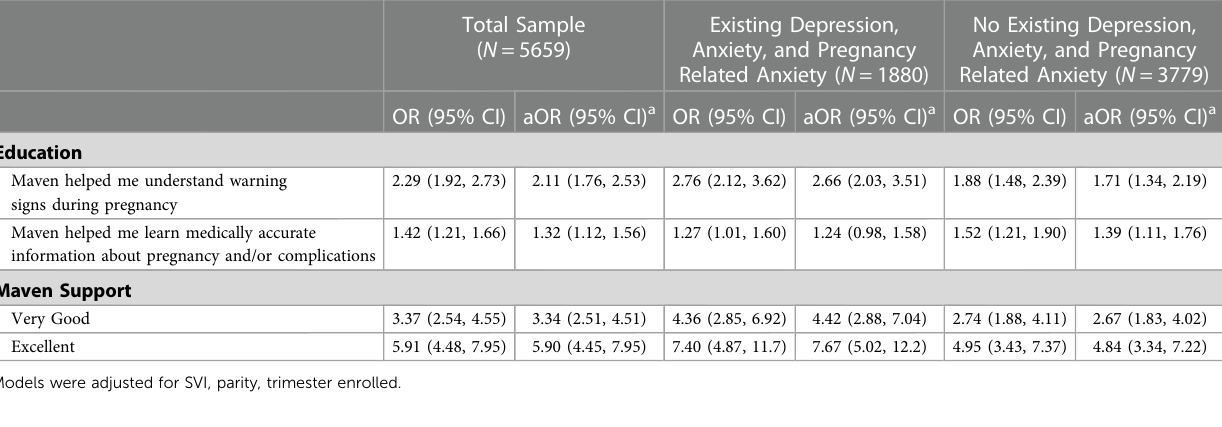
TABLE 4 Effect of education and support on mental health management.